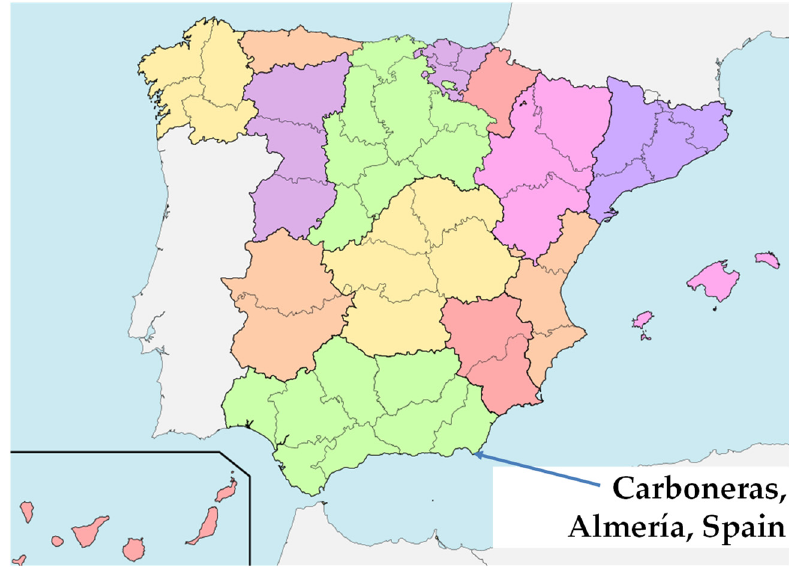
Figure 1. Map of Carboneras in Almeria, in the South of Spain.